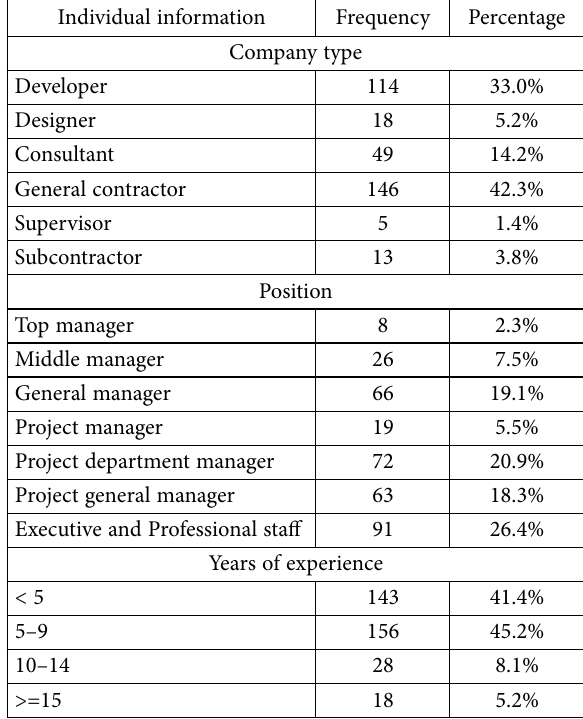
Table 2. Demographic characteristics of